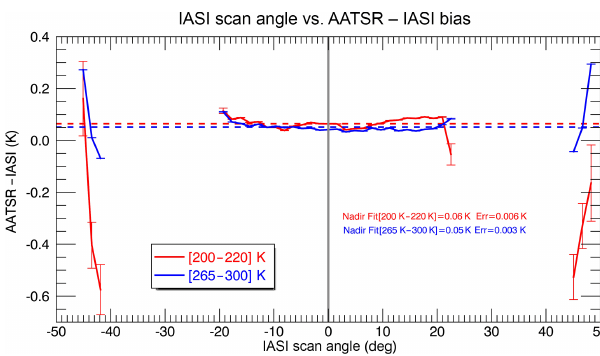
cold (200–220K) and SST (265–300K) temperature ranges. Nei- ther AATSR nor IASI show any scan angle dependence in the − 20 to + 20 ◦ scan angle